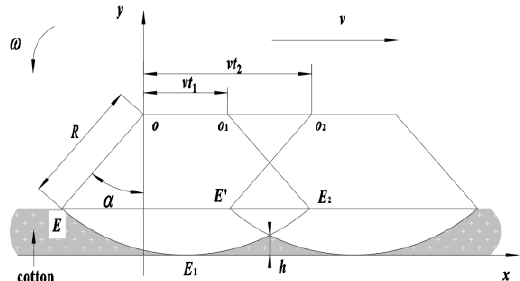
Figure 4. Adjacent serrated tooth end motion trajectory. v is the operating speed of the machine (m/s); ω is the angular speed of the serrated disc, (rad·s −1 ); O , O 1 , and O 2 are the centers of rotation of the serrated disc at different moments; E is the initial point of the serrated tooth end into the cotton; E 1 is the deepest point of the serrated tooth end into the cotton; E 2 is the point of the serrated tooth end out of the cotton; E is the point of the adjacent serrated tooth end into the cotton; vt 1 is the displacement of the rotary center of the previous serrated tooth in time t 1 (mm); vt 2 is the displacement of the rotary center of the latter saw tooth in time t 2 (mm).